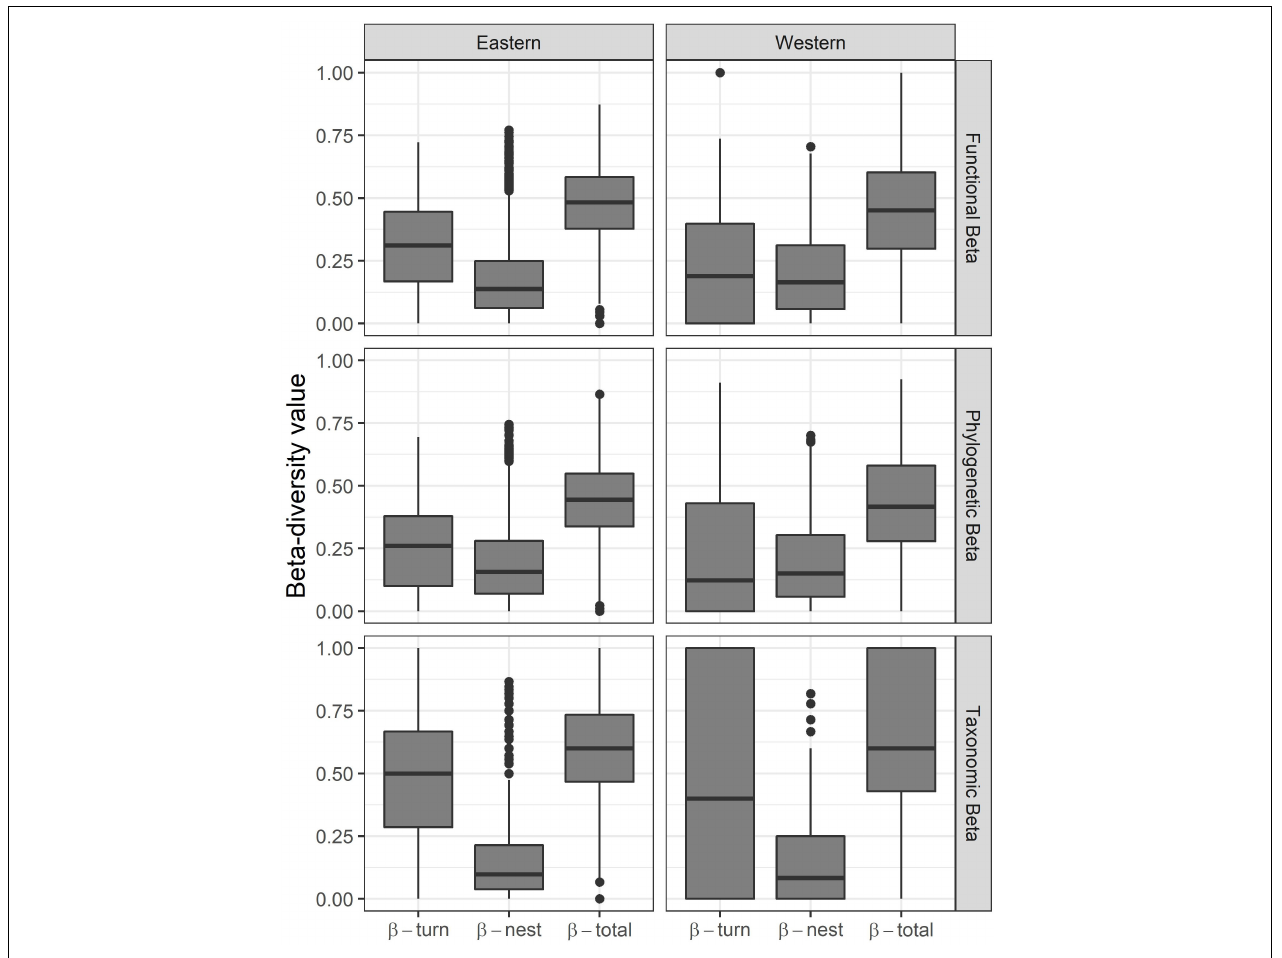
FIGURE 4 | Box-whisker plots showing beta diversity components ( β -turnover, β -nestedness, β -total) of the river bird community in the E and W